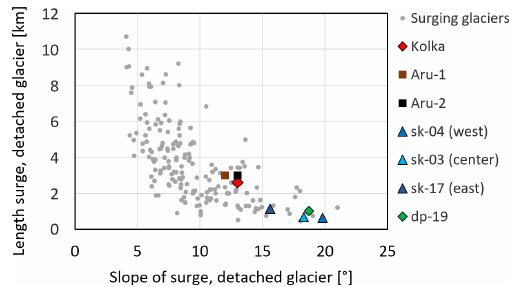
Figure 11. Horizontal length over slope of the surging part of a glacier in the Pamir Mountains and surface slope of the detached parts of glacier detachments. Figure 12. (a–d) NDVI before and after the sk-16b and dp-19 de- tachments. The white bar in (a) indicates the end of the runout of the sk-17 and sk-19 events; the sk-16b mudflow in August 2016 trav- eled further downstream. (e, f) NDVI time series of the mean NDVI over the eroded area (black box in a–d ) of the sk-16b and dp-19 events. Vegetation hardly recovered within 2 years. (g) NDVI time series from the runout of the Kolka–Karmadon detachment. Veg- etation recovered within about 10–15 years. Copernicus